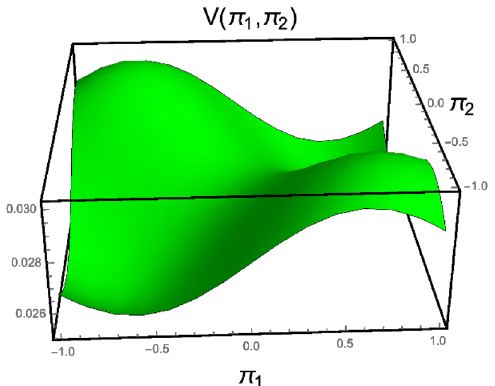
2 = 1, (cid:21) = 1, (cid:22) = 1. The has a regular mass where as (cid:25) 1 + (cid:25) 2 p has a 2 2